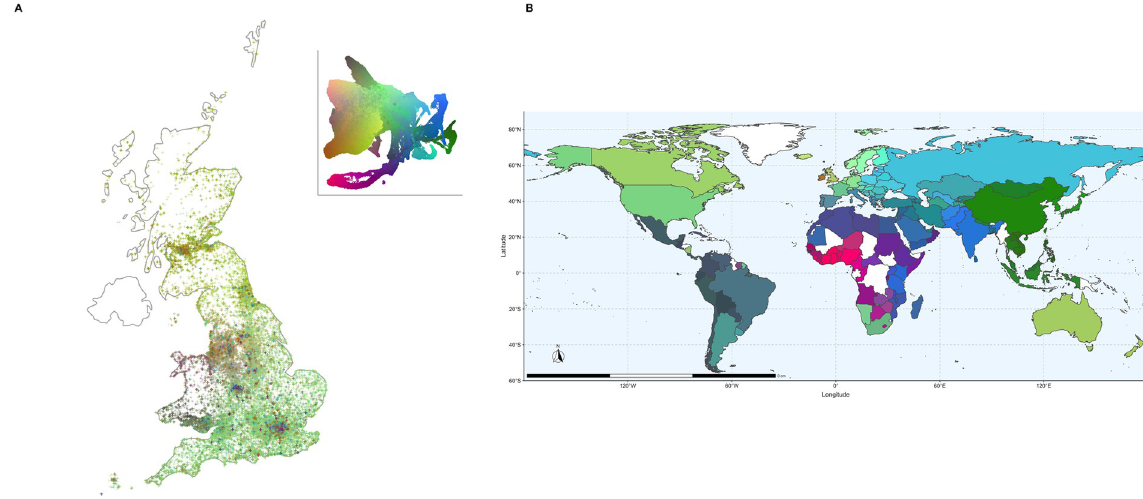
Fig 5. Maps coloured by 3D UMAP projections of the top 20 principal components of the UKBB. Each individual is assigned a 3D RGB vector based on 3D UMAP coordinates (a flattened projection is in the top right of panel A). Individuals who are closer to each other in the projection will be closer in colour in the maps. More details on colouring, as well as randomization of points to protect participant privacy, are available in the materials and methods. ( A ) Each point is an individual placed based on where they live. Patterns in genetic similarity are visible in Scotland, South England, North and South Wales, the East and West Midlands, and major urban centres. ( B ) Geographic distribution of UMAP coordinates. Using the country of birth of individuals in the UKBB, we colour countries by the closeness in 3D UMAP space of those born there. Broad patterns of similarity appear in East Asia, South Asia, North African and the Middle East, West Africa, and South America. Differences between neighbouring countries can reflect both ancient population structure and recent differences in migration history. Evidence of migrations related to colonialism are visible with, e.g., European ancestry in South Africa and South Asian ancestry in Kenya and Tanzania. Because of the large number of White British individuals born abroad, to avoid skewing the colour scale they were not included unless they were born in the UK, Europe, Australia, Canada, or the United States, where UKBB participants already tended to have European ancestry. Zoomed maps of East Asia, the Caribbean, and Europe are available in S19, S20, and S21 Figs, respectively.